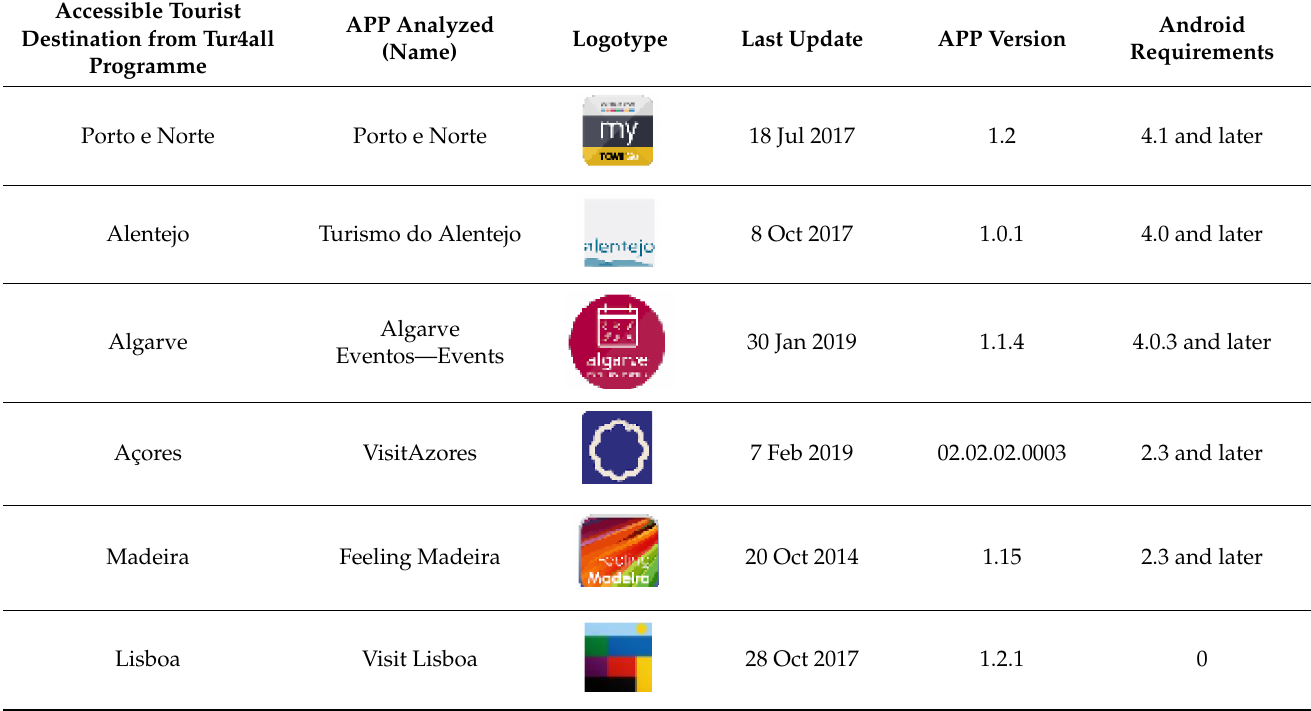
Table A4. Portuguese accessible destinations from the Tur4all.pt platform analyzed as a sample from the accessibility point of view of their mobile tourism applications.